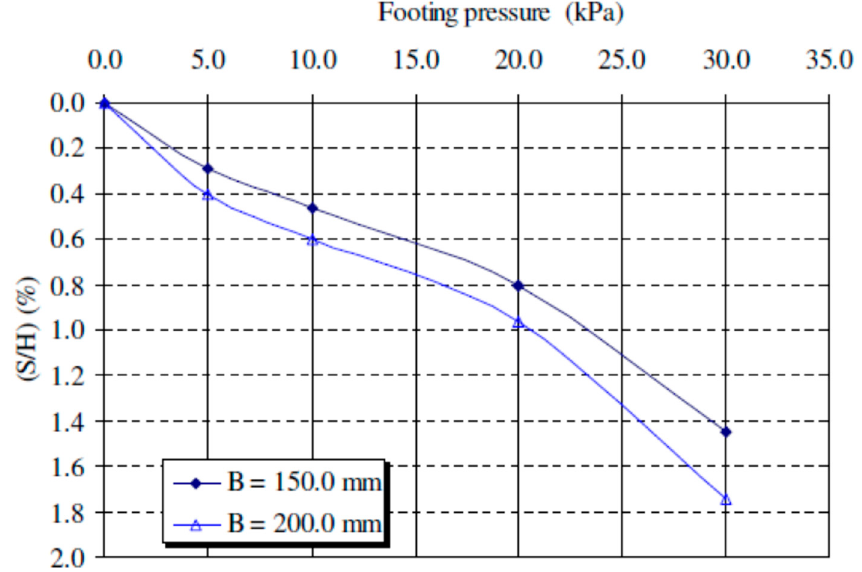
Figure 20. Influence of footing width on the settlement of the footing.